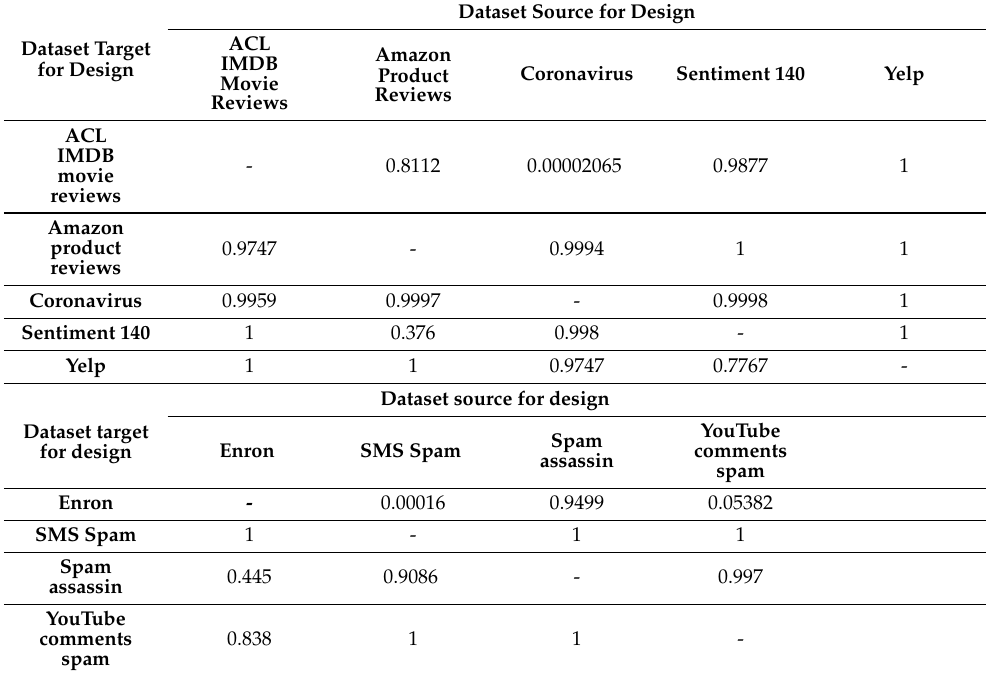
Table 14. Results of a Mann–Whitney U test conducted at a statistical significance of 5% when comparing running the SPHH with transfer learning and without transfer learning for the text processing